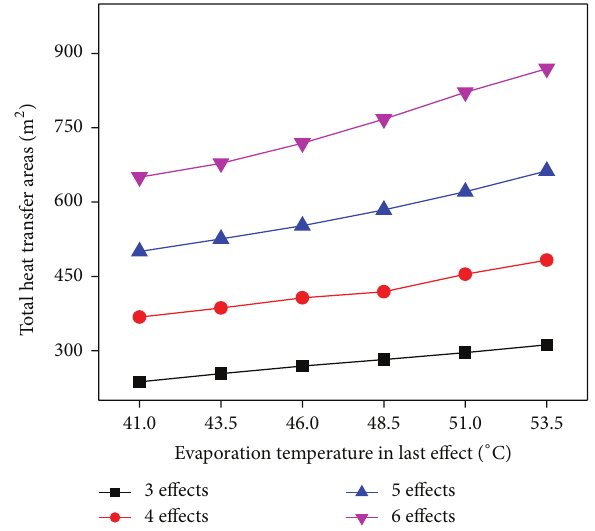
Figure 2: Variation of steam consumption with evaporation tem- perature in last effect.